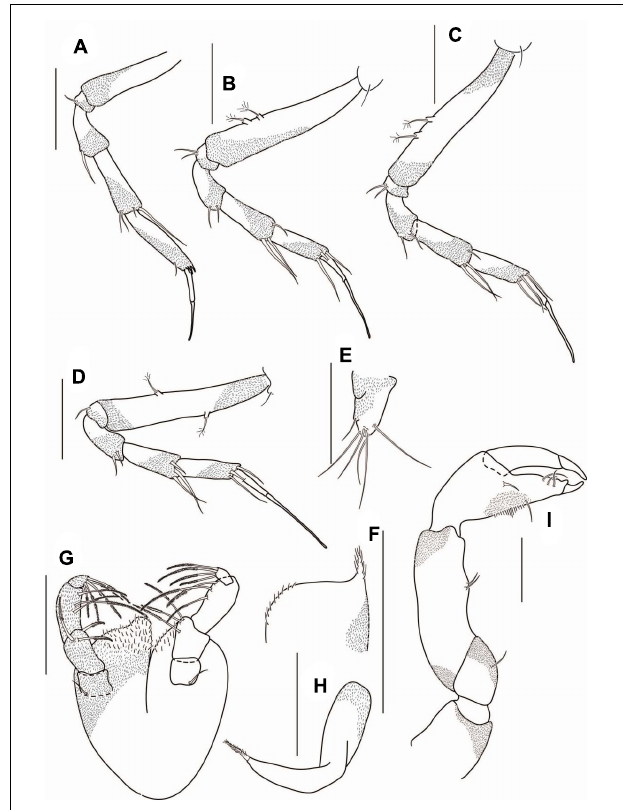
FIGURE 13 | Agathotanais oharai n. sp., neuter, paratype ( A–E : NMV J 74742), juvenile male ( F–I : NMV J 74725). (A) pereopod-3; (B) pereopod-4; (C) pereopod-5; (D) pereopod-6; (E) uropod; (F) labium; (G) maxilliped; (H) epignath; (I) cheliped. Scale bars: (A–E , I) = 100 µ m; (F–H) = 10 µ m.